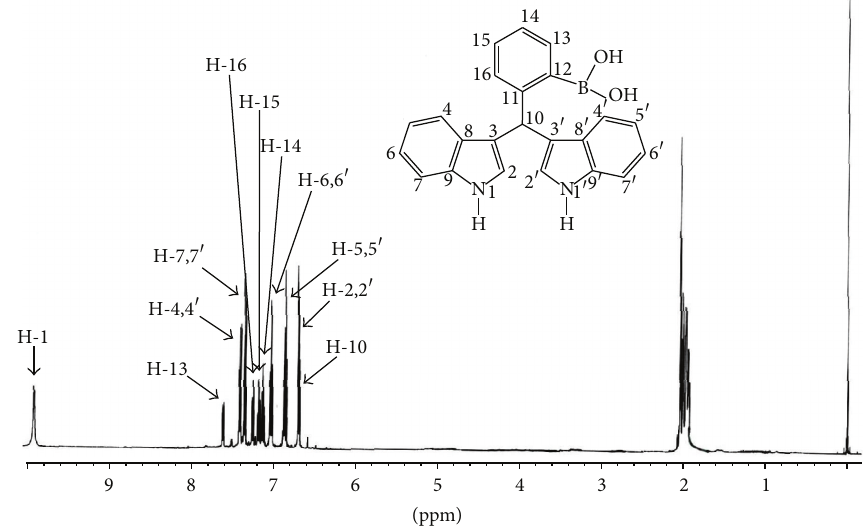
Figure 1: 1 H NMR (acetone-d 6 /TMS) of 5 determined at 500 MHz.